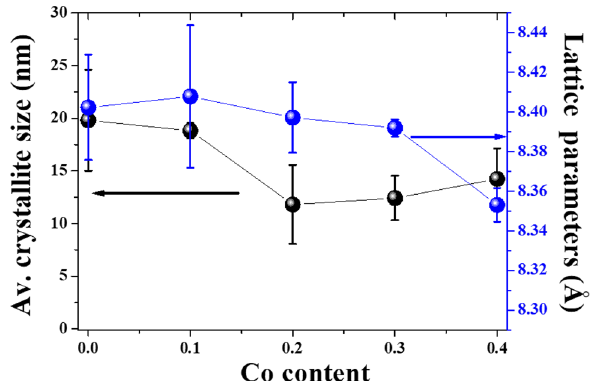
Figure 4. Plots of the lattice parameter ( a ) and Av. crystallite size ( D XRD ) of Co x Zn 1−x Fe 2 O 4 (x = 0.0–0.4) NPs as a function of Co